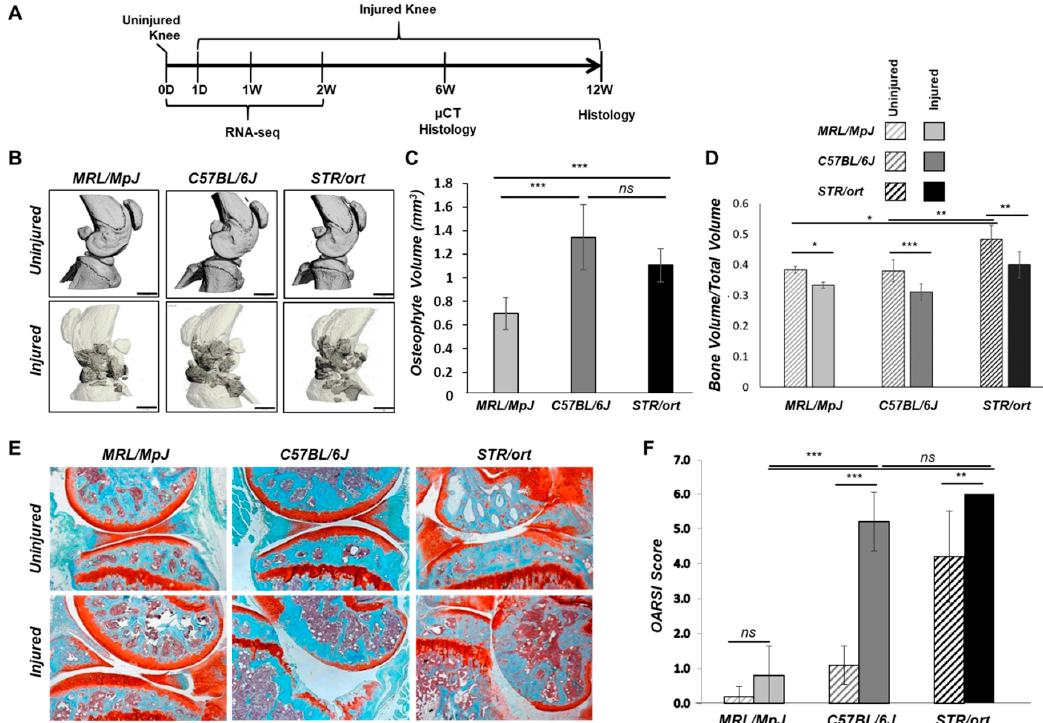
Figure 1. Anterior cruciate ligament (ACL) injury leads to post ‐ traumatic osteoarthritis (PTOA) in C57BL/6J and STR/ort but not in MRL/MpJ mice . Knee joints were injured at 10 ‐ weeks of age. ( A